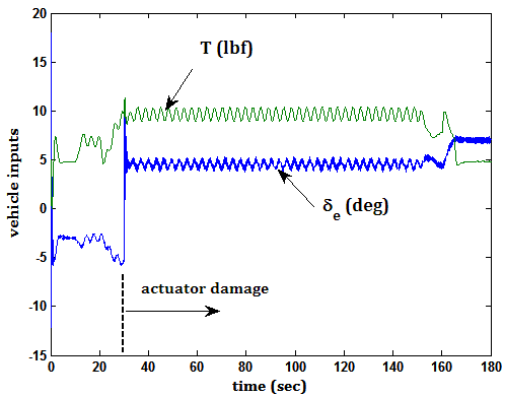
Figure 16. Elevator and thrust inputs for Task 4.